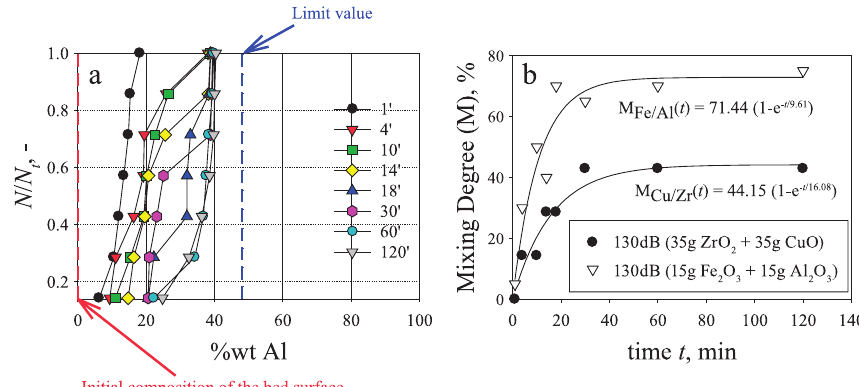
Fig. 11 (a) Cumulative distribution of aggregates at different times for the ZrO 2 and CuO mixing test (130 dB–120 Hz); (b) time-dependence of aggregates’ mixing degree for the ZrO 2 and CuO mixing test and for the Al 2 O 3 and Fe 2 O 3 B mixing test (130 dB–120